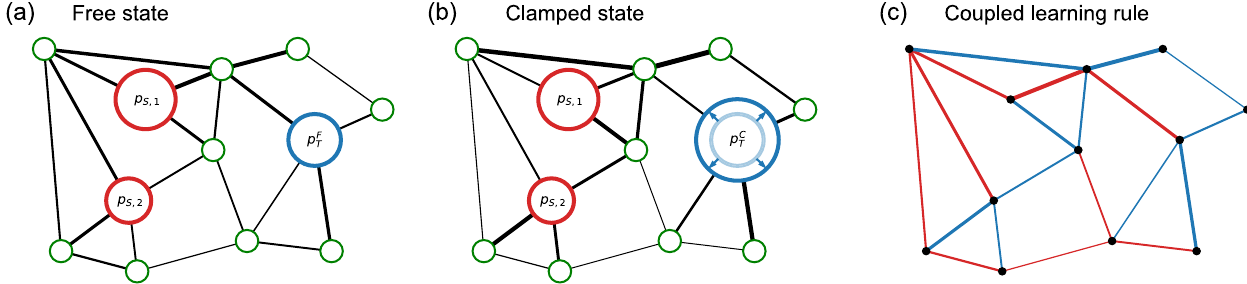
FIG. 1. Coupled learning in flow networks. (a) In the free phase, node pressures are constrained such that source nodes (red) have specific pressure values p S . The target node pressures p T and the dissipated power at all pipes P j attain their steady-state values due to the natural flow processes in the network. (b) In the clamped phase, a supervisor constrains the target node pressures so that they are slightly closer to their desired values compared to the free state. (c) A strictly local learning rule, i.e., the modification of pipe conductance according to its response, is proportional to the difference in dissipated power between the free and clamped states. The learning rule thus couples the pressures at the source and target